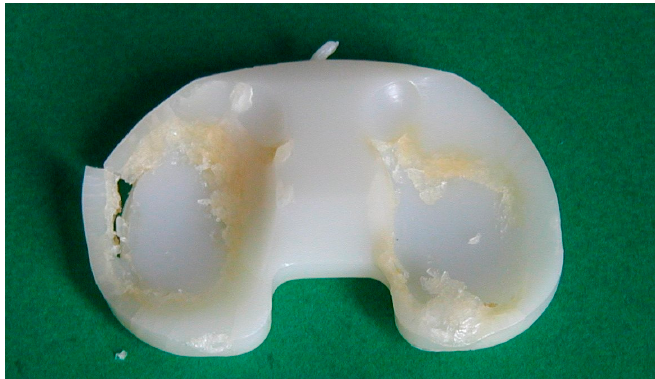
Figure 3. Retrieved polyethylene tibial insert showing severe wear damage, including severe delamination and wear (10 years in vivo).